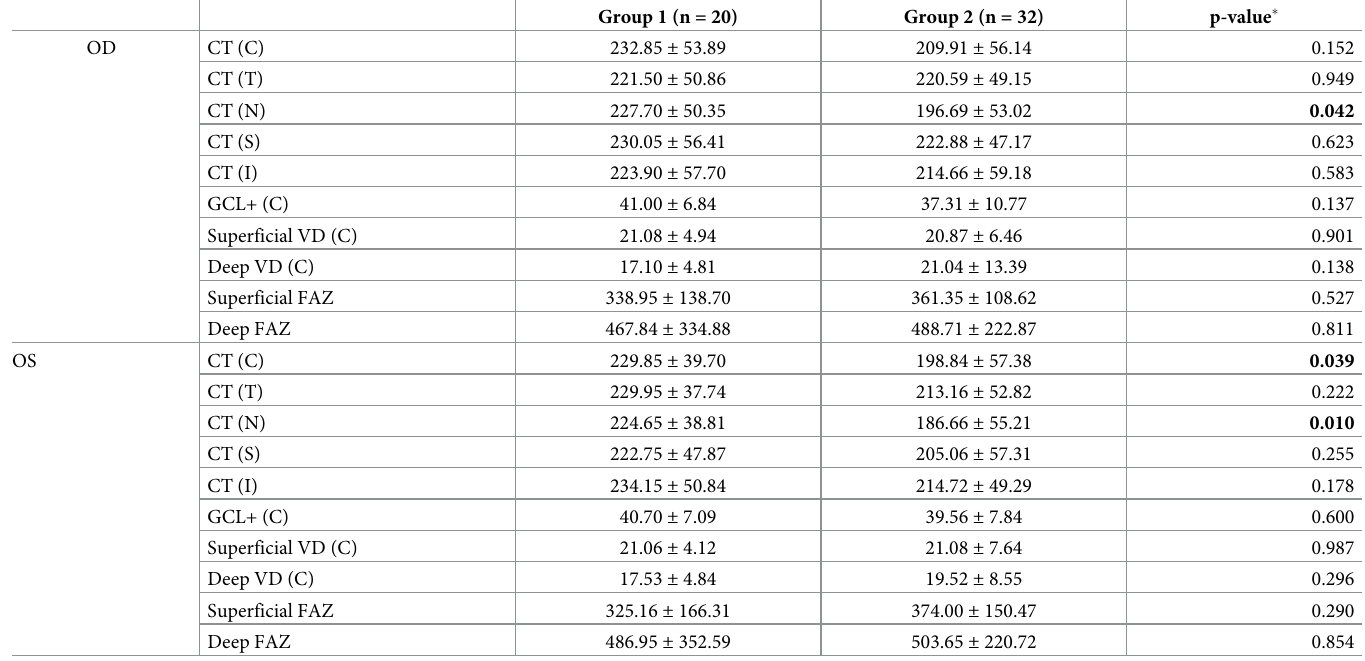
Table 2. Choroidal and retinal vascularity parameters in pregnant women with preeclampsia.